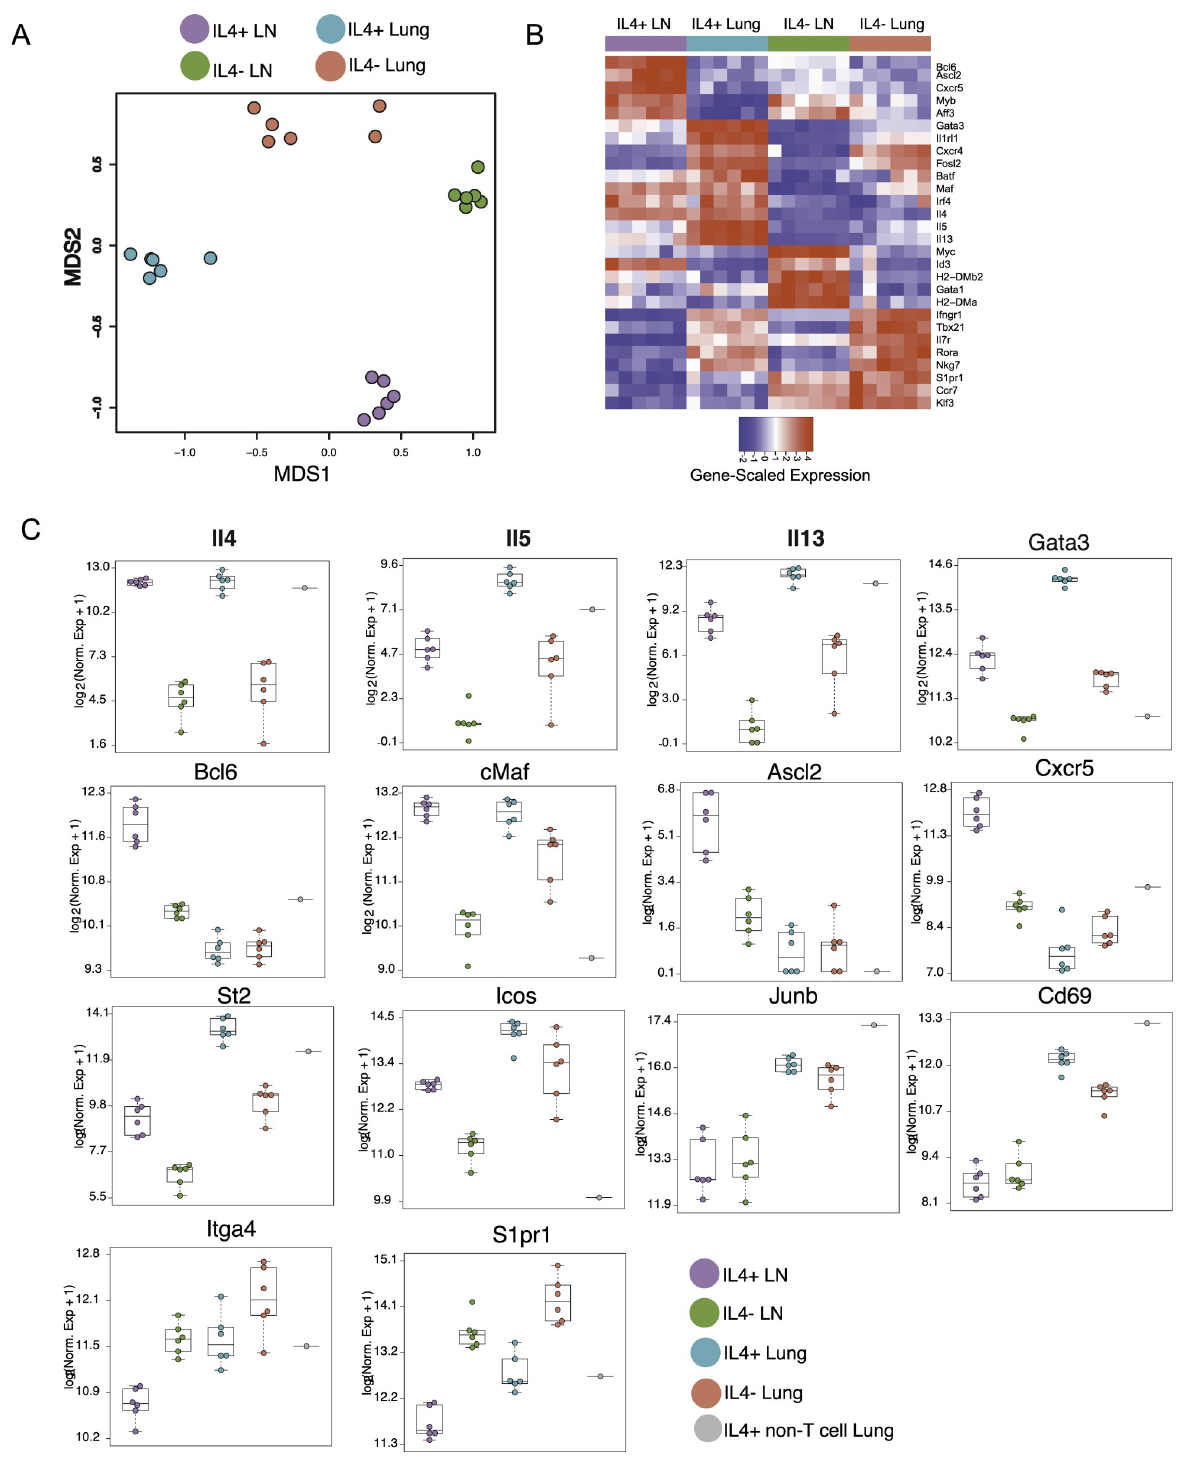
Fig 6. AmpliSeq reveals heterogeneity among IL-4-expressing CD4 + T cell populations in the lymph nodes and lung during helminth infection. IL-4 4get C57BL/6 mice were infected with N . brasiliensis and GFP + and GFP - CD4 + T cells from the lung and mediastinal lymph nodes were harvested and sorted nine days post-infection for bulk RNA AmpliSeq analysis. (A) Multi-dimensional scaling comparing IL-4-competent and IL-4 - CD4 + T cell populations isolated from the lung and lymph nodes of six mice infected on six different occasions. (B) Heat map showing the expression of select, characteristic genes in each CD4 + T cell population. (C) Log 2 -normalized expression of indicated genes within IL- 4-competent and IL-4 - CD4 + T cell populations; n = 6, 1 mouse each from six different infections.